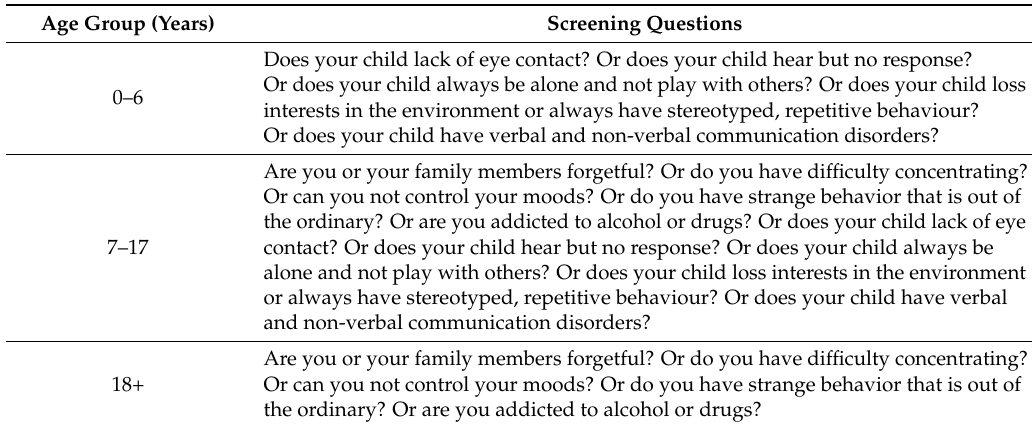
Table 2. Screening questions for mental disability in different age groups in